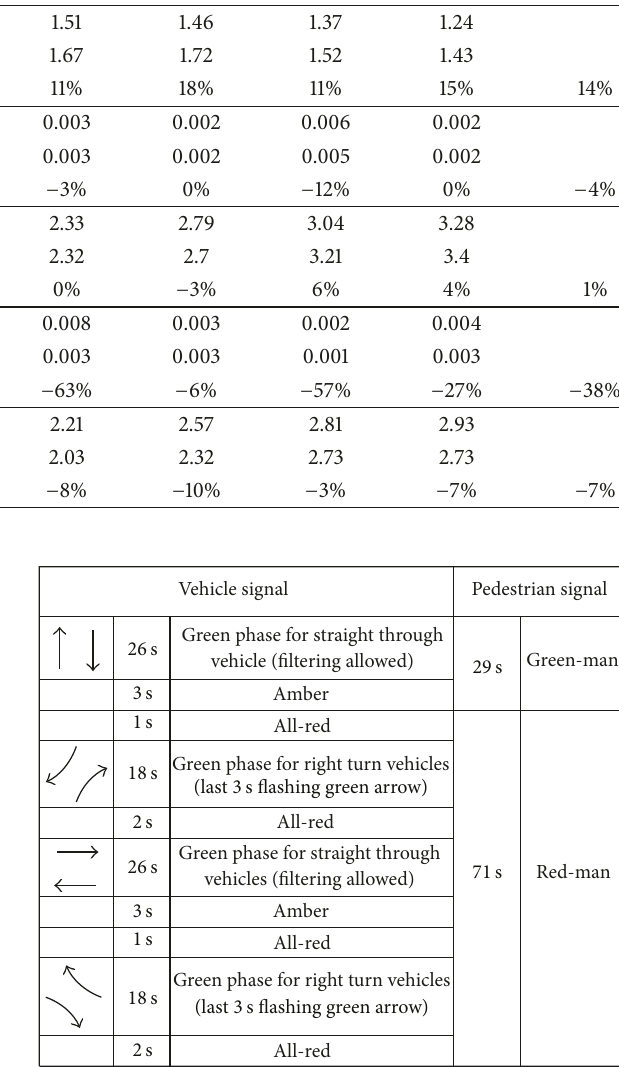
Figure 6: Geometric layouts of simulated pedestrian crosswalk. crosswalk-output at non-GMCD crosswalk]/output at non- GMCD crosswalk × 100%. The impact of GMCD at different traffic conditions can be summarized in Table 7 and Figure 8.